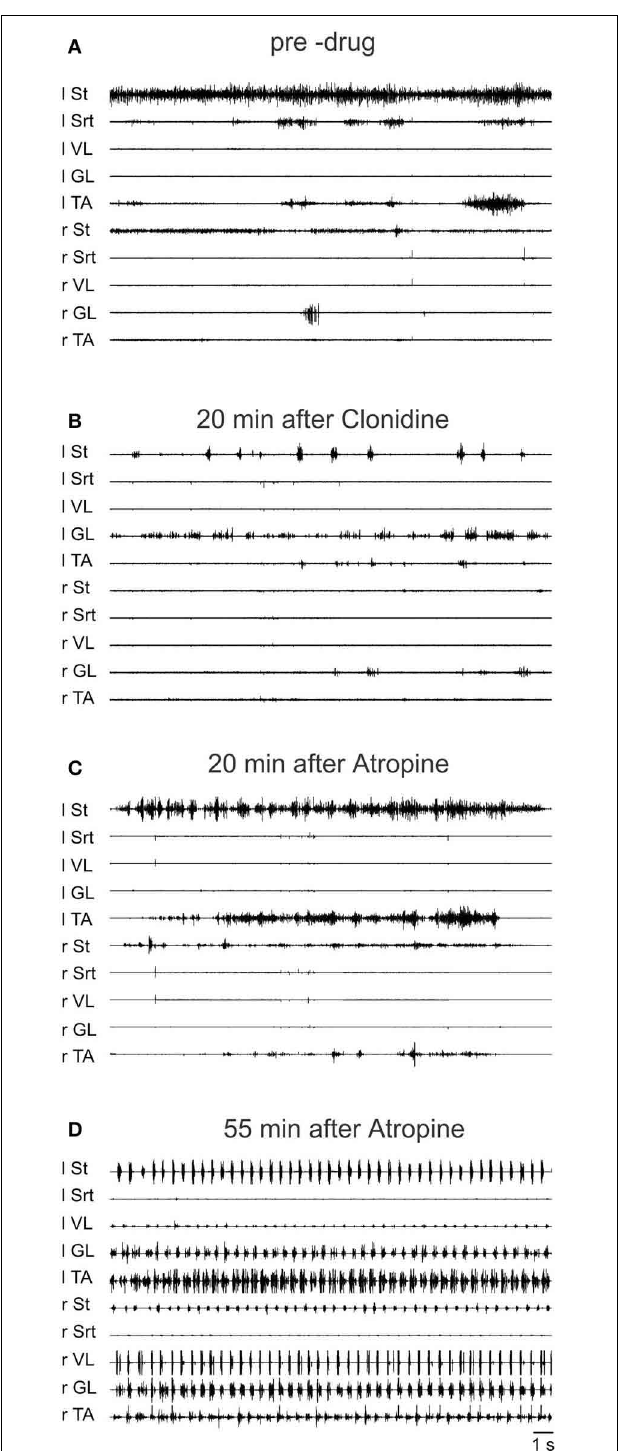
FIGURE 13 | Sub-thresholdclonidineisfacilitatedbyatropineinanacute spinal cat. (A) Pre-drug records of EMG signals from hindlimbs muscles; (B) 20min after administration of a small volume of clonidine i.v. (20 μ g/kg); (C) 20min after bath atropine (1.5ml of a solution containing 1mg/ml of atropine) over L3-L4 and 40min post clonidine; (D) 55min after atropine application, a vigorous pattern of locomotion is represented by the EMG